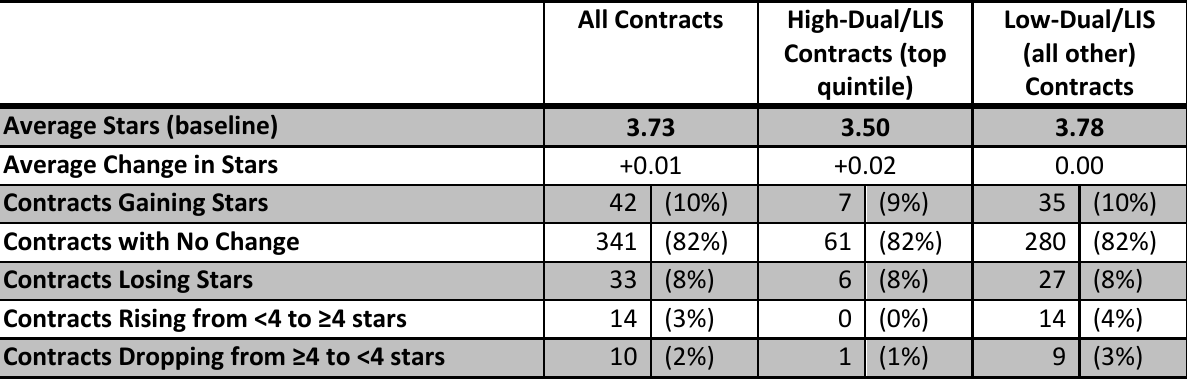
Table 8.9: Adjusting 19 Clinical Measures for